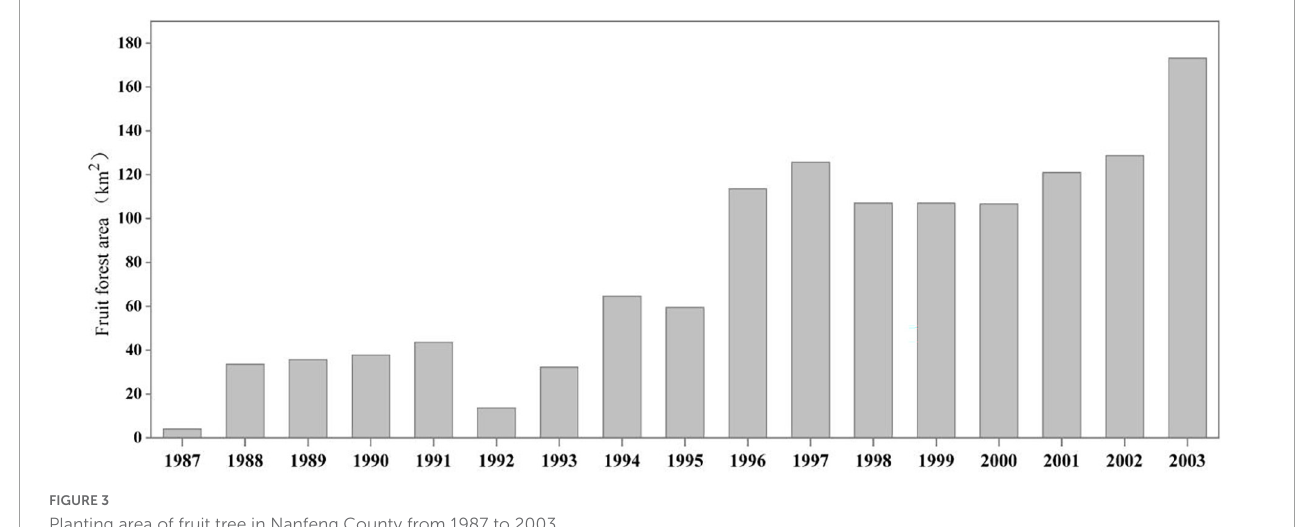
FIGURE3 Planting area of fruit tree in Nanfeng County from 1987 to 2003.